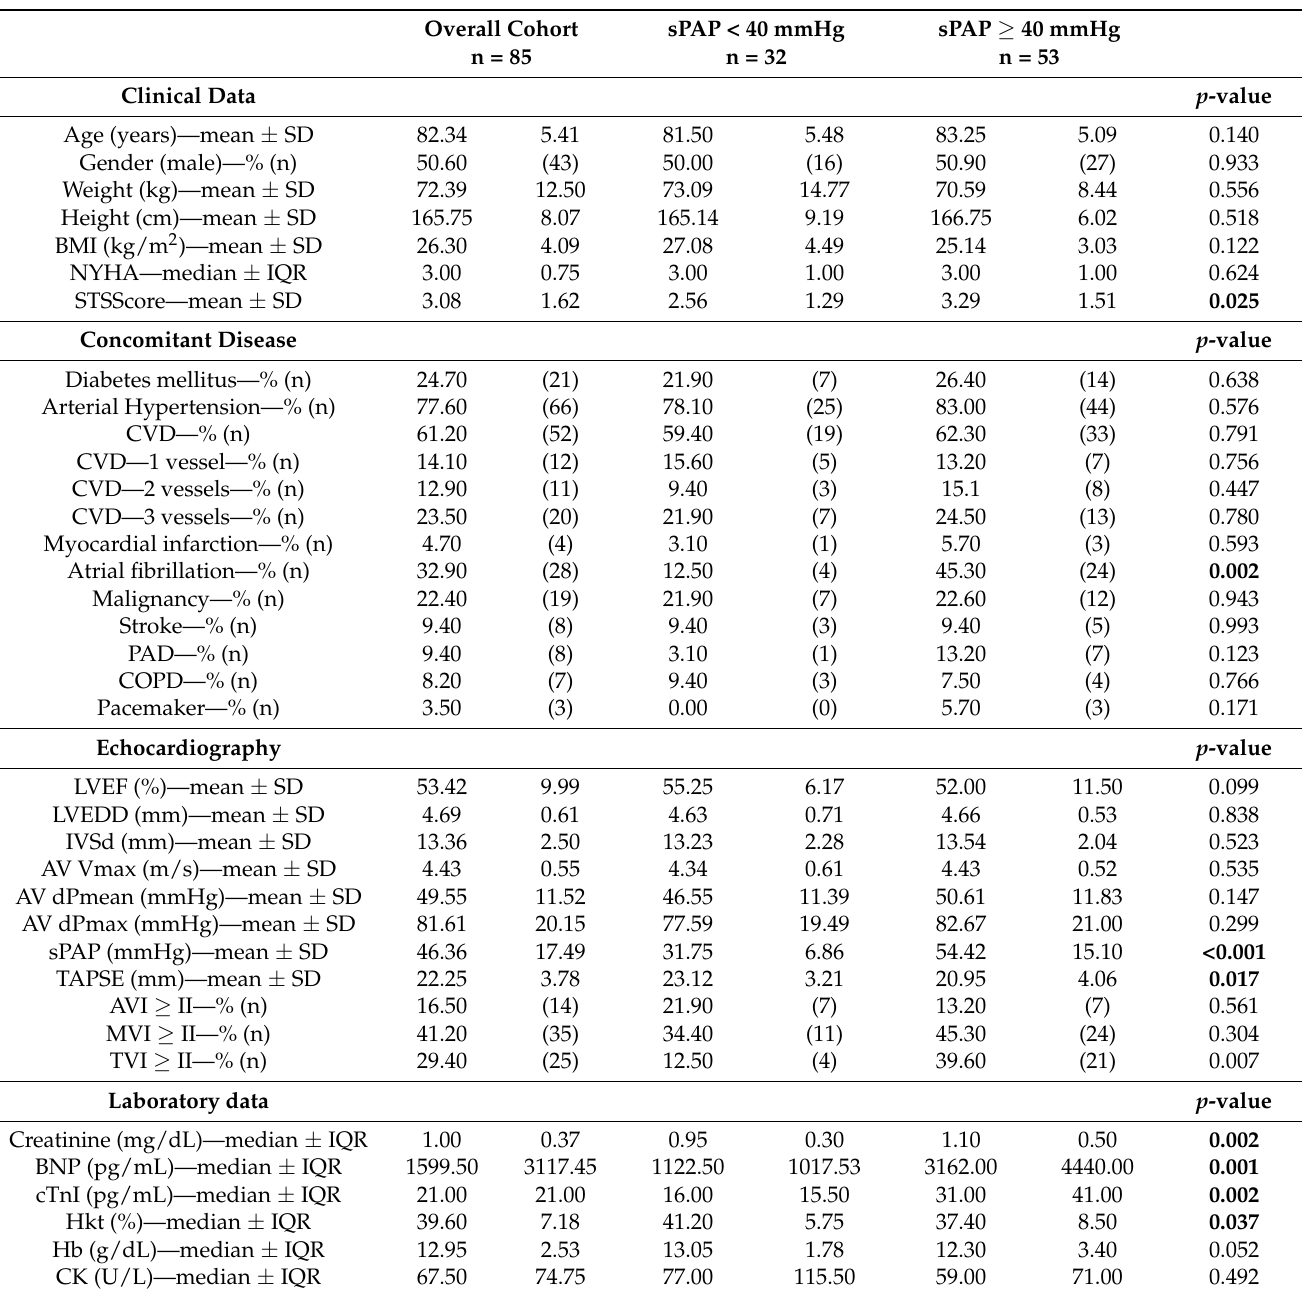
Table 1. Baseline characteristics of study cohort. sPAP: systolic pulmonary artery pressure; BMI: body mass index; CVD: cardiovascular disease; PAD: peripheral artery disease; COPD: chronic obstructive pulmonary disease; LVEF: left ventricular ejection fraction; LVEDD: left ventricular end-diastolic diameter; IVSd: interventricular septal thickness at diastole; AV Vmax: maximal velocity over